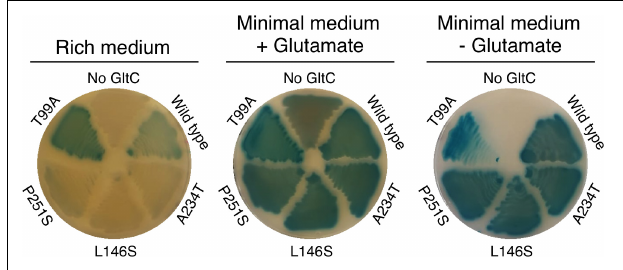
FIGURE 5 | Activity of the P gltA promoter in the strains BP881 ( P gltA -lacZ gltC − rocG + gudB − ) + pBQ200 (no GltC), BP881 + pGP907 (Wild type GltC), BP881 + pBP735 (GltC A234T), BP881 + pBP727 (GltC L146S), BP881 + pBP726 (GltC P251S), and BP881 + pBP718 (GltC T99A)